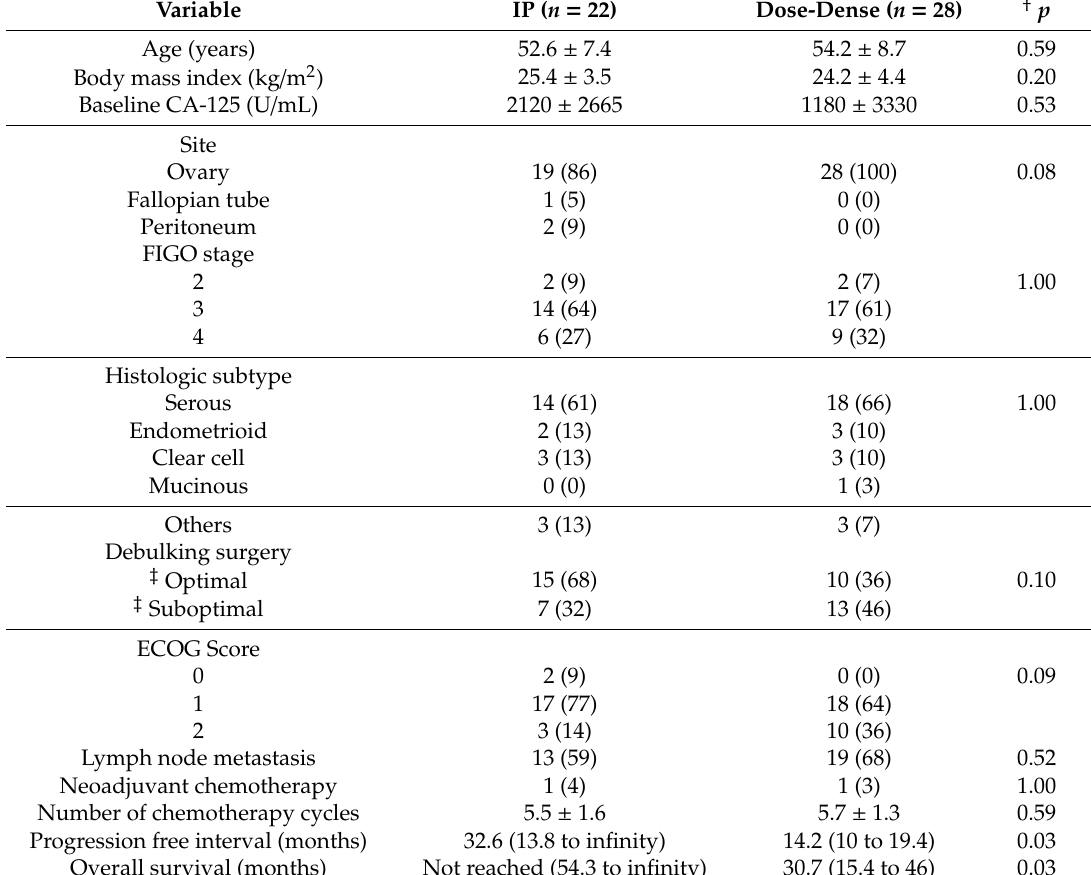
Table 1. Baseline characteristics of women with advanced ovarian, fallopian tube or primary peritoneal cancer ( n =